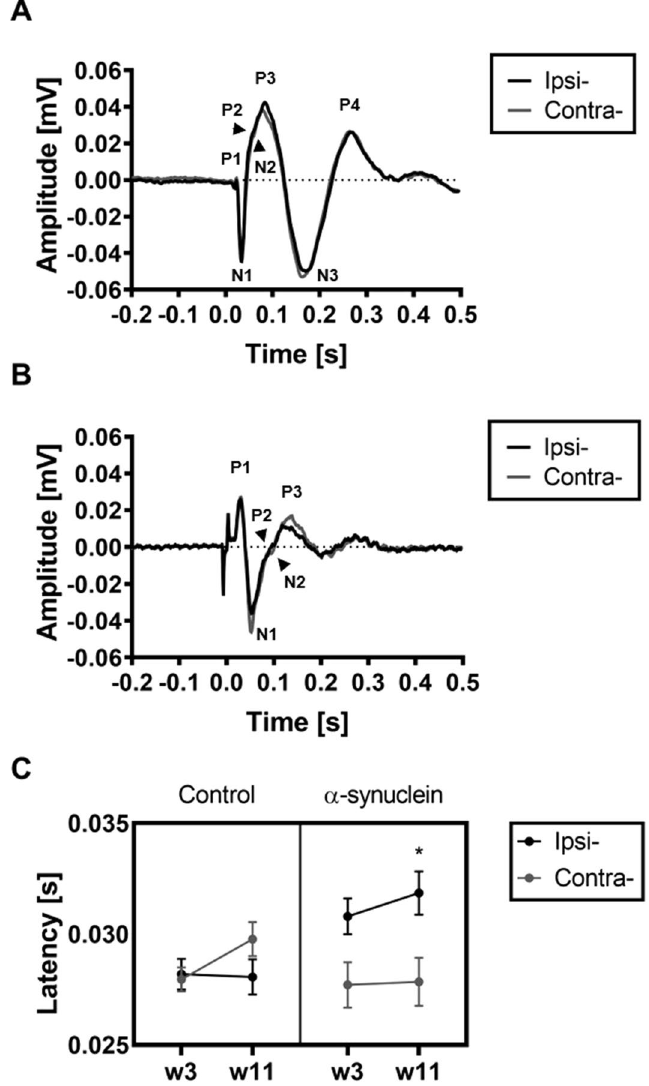
Figure 2. Unilateral α-synuclein overexpression in the SC causes a delay of the first positive peak (P1) of the VEP. ( A ) The grand average VEP waveforms from the visual cortex recorded ipsilateral (black) and contralateral (grey) to the injection of AAV-α-synuclein at week 11 (averaged across colour). ( B ) The grand average VEP waveform from the SC (averaged across colour) recorded from animals expressing α-synuclein in the left substantia nigra ipsilateral (black) and contralateral (grey) to the injection of AAV-α-synuclein at week 11 (averaged across colour). The peak around time 0 is an electrical artefact from the onset/offset of the VEP stimulus. ( C ) Latency of the P1 peak from the waveform recorded from the SC shown as mean ± SEM at week 3 and week 11 for both α-synuclein and control animals. The P1 recorded ipsilateral to the AAV-α-synuclein injection is significantly delayed at week 11 compared to P1 recorded contralateral to the injection. * p <